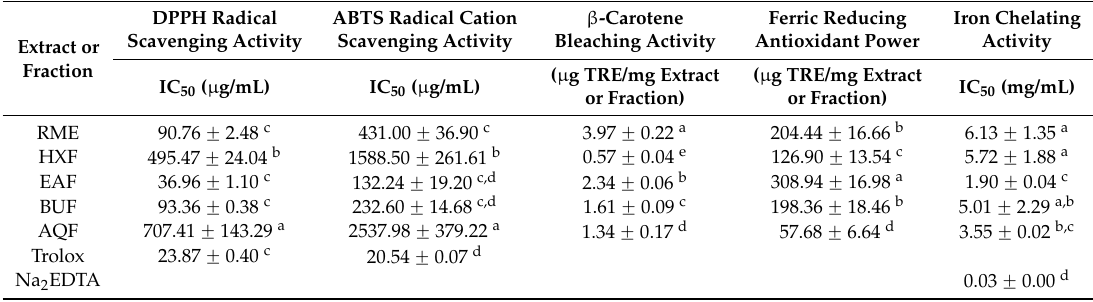
Table 3. Antioxidant activities of M. latifolia rhizome methanolic extract and its fractions.